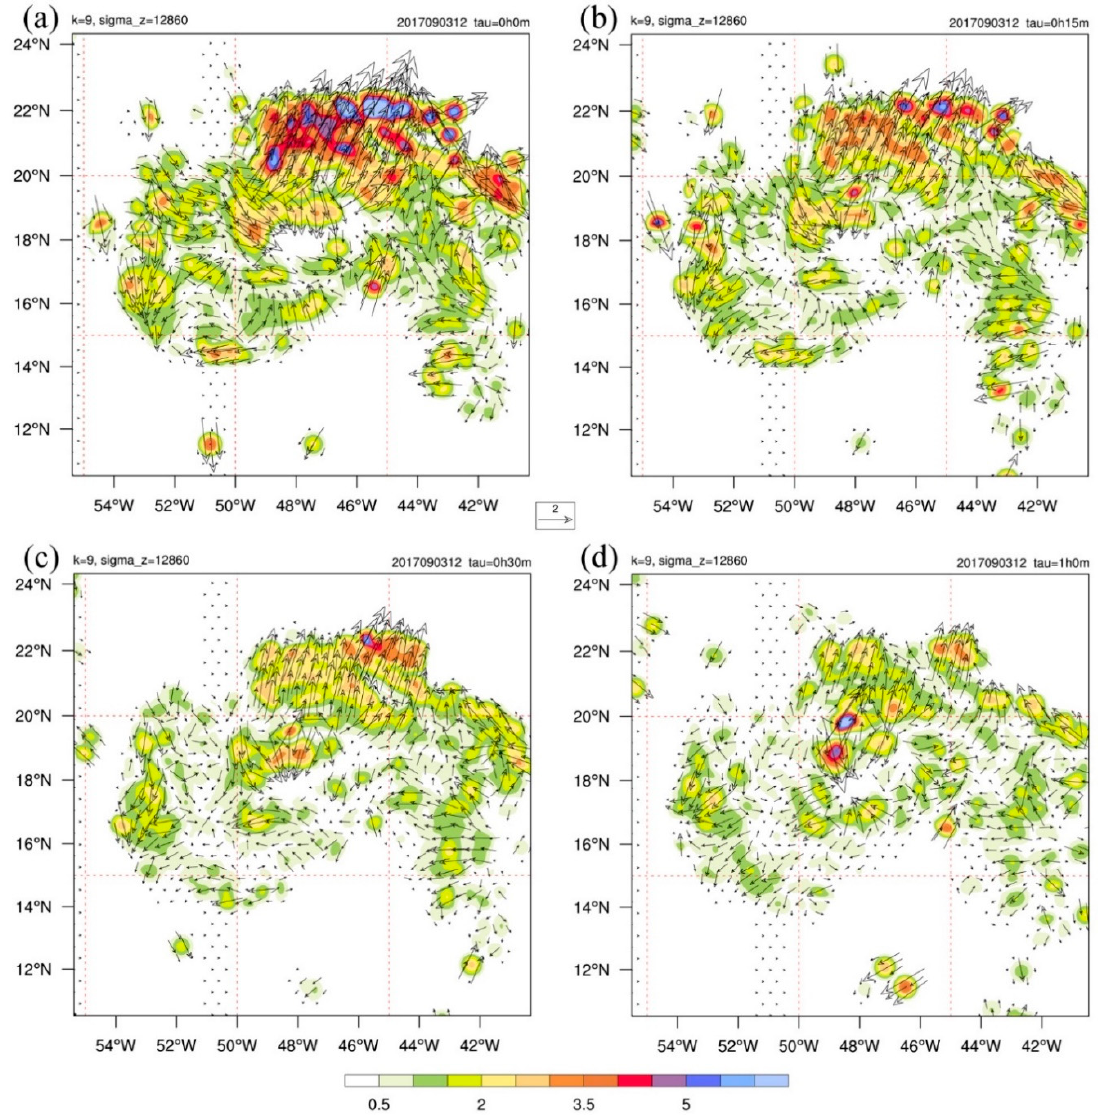
Figure 7. As in Figure 6, except for the 15 min AMV-based FCDI wind increments (m s − 1 ; color bar at bottom and 2 m s − 1 vector magnitude indicated by arrow in middle) at ( a ) tau = 0 h, ( b ) tau = 15 min, ( c ) tau = 30 min, and ( d ) tau = 1 h.